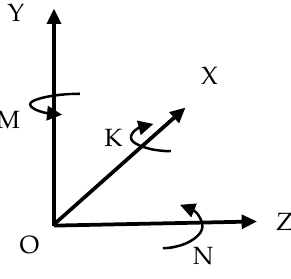
Figure 2. Six-dimensional component of viscous hydrodynamic F.